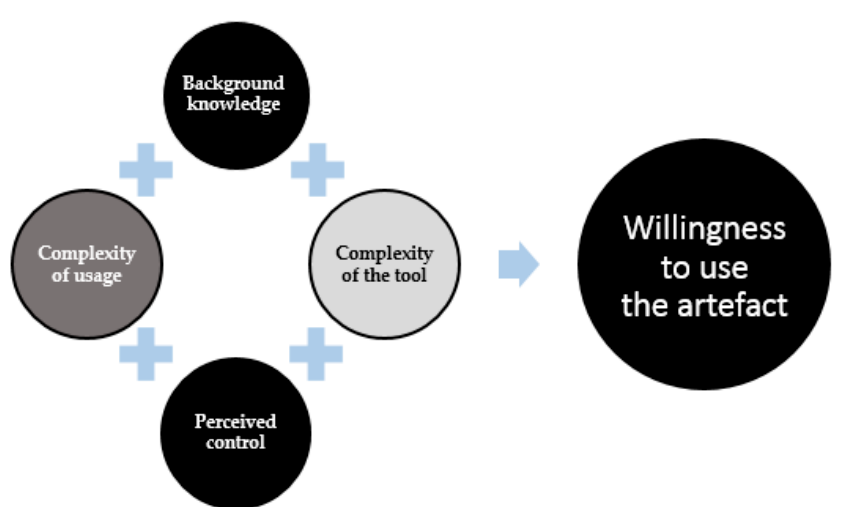
Figure 2. High student willingness to use the artefact as influenced by the high perceived control.